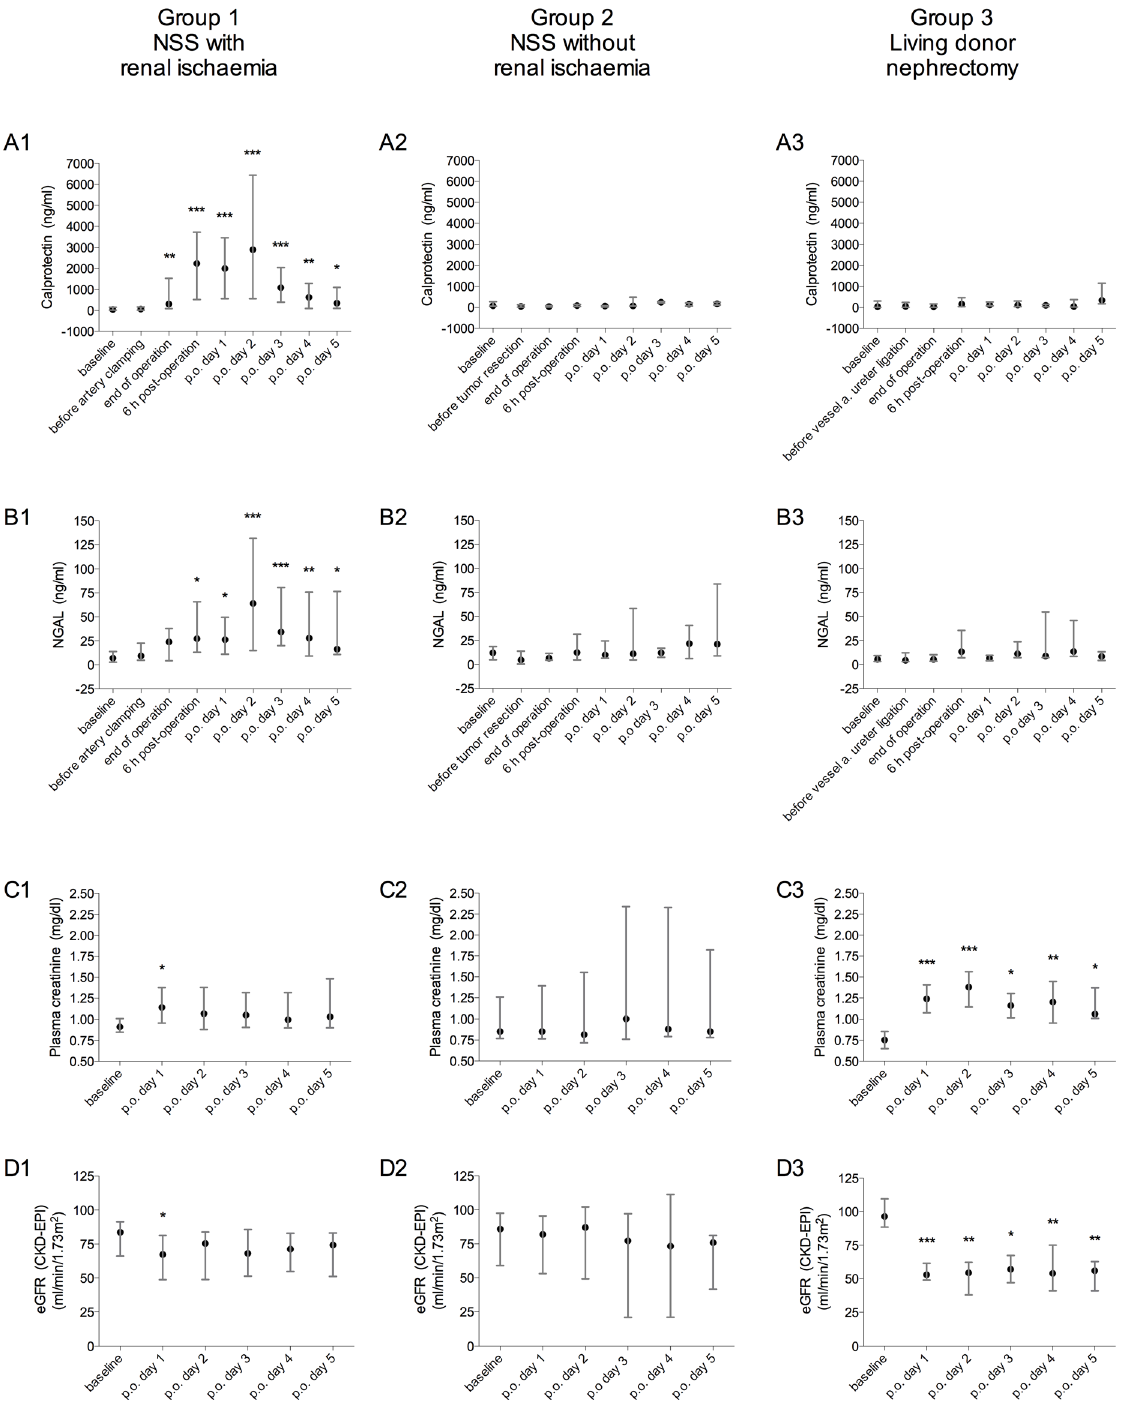
Fig 1. Concentrations of (A) urinary calprotectin, (B) urinary neutrophil gelatinase — associated lipocalin (NGAL), (C) plasma creatinine, and (D) the estimated glomerular filtration rate (eGFR) in patients undergoing nephron sparing surgery (NSS) for kidney tumours with renal pedicle clamping (renal ischaemia, Group 1) or without renal ischaemia (Group 2), and in patients undergoing radical nephrectomy for living kidney donation (Group 3). Data are presented as median and interquartile range. Asterisks indicate significant changes from baseline in a non-parametric analysis of variance (Kruskal-Wallis test, corrected for multiple comparisons by Dunn ’ s test as a post hoc pairwise multiple comparison). p.o., post-operative. * p < 0.05, ** p < 0.01, *** p < 0.001.